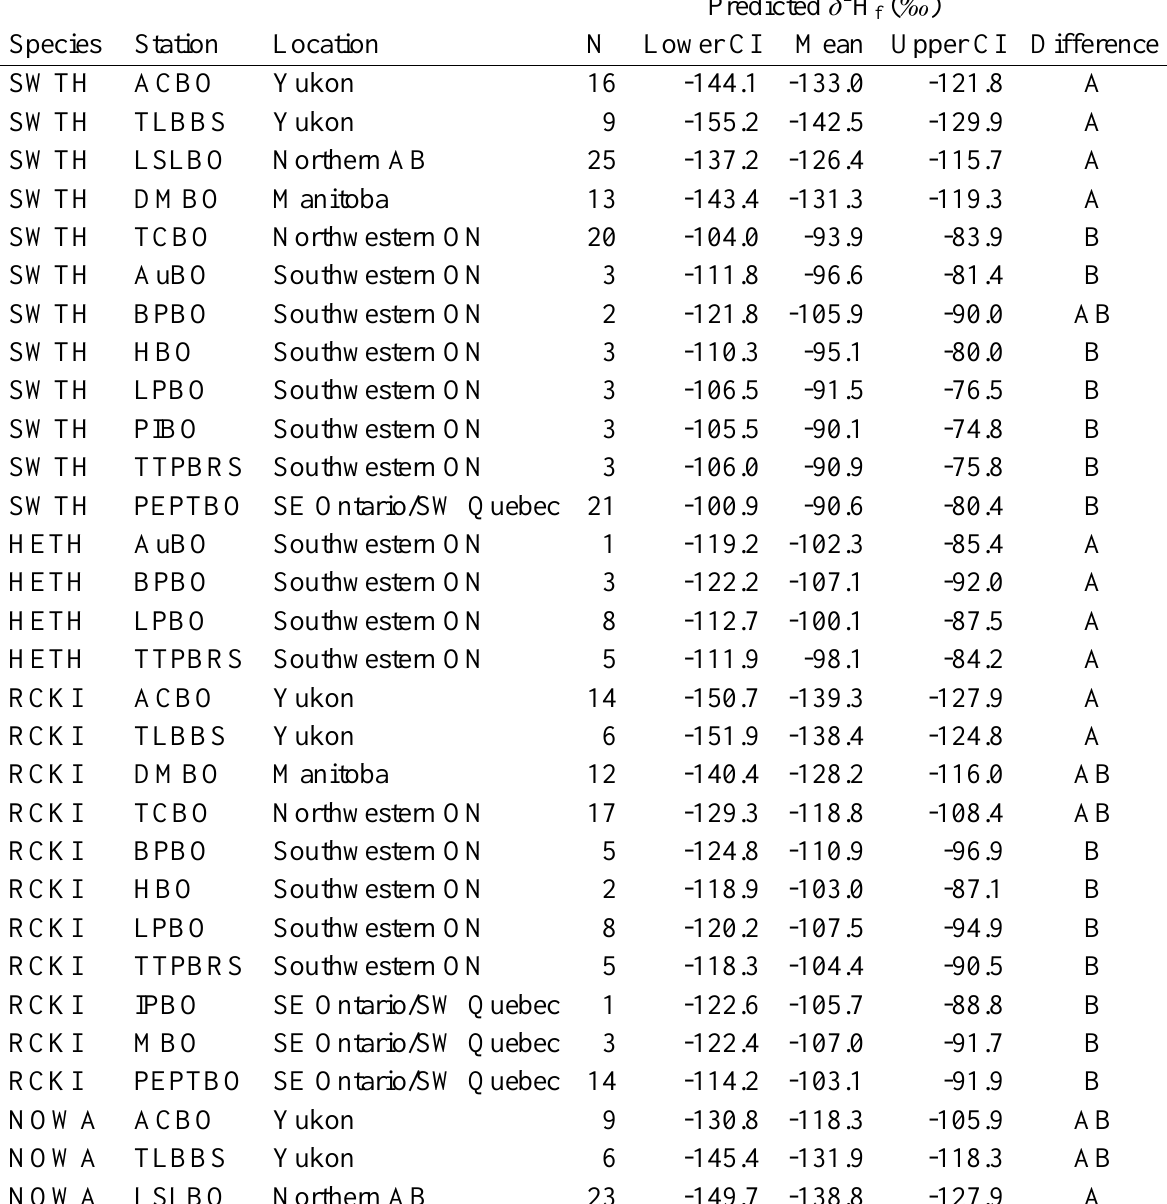
Table A1.1. Predicted mean δ 2 H and 95% Confidence Intervals from linear mixed effects models f examining variation in δ 2 H from 12 species of passerine captured at Canadian Migration Monitoring f Network Stations during spring migration (n = 966